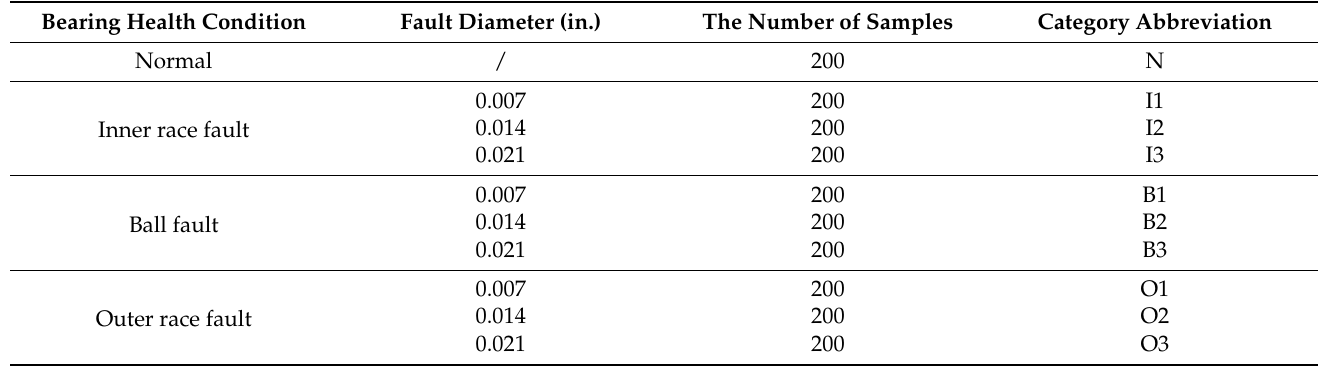
Table 2. Bearing dataset settings under four working loads (0 hp, 1 hp, 2 hp, and 3 hp).